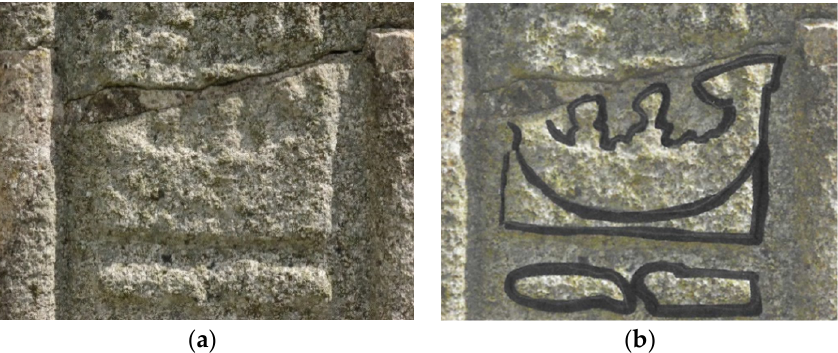
Figure 5. ( a , b ). Noah’s Ark, W2, Donaghmore cross. Early ninth century. St Bartholemew’s Church of Ireland Graveyard, Donaghmore, Co. Down. Photograph: Megan Henvey; Interpretive Sketch: Megan Henvey.